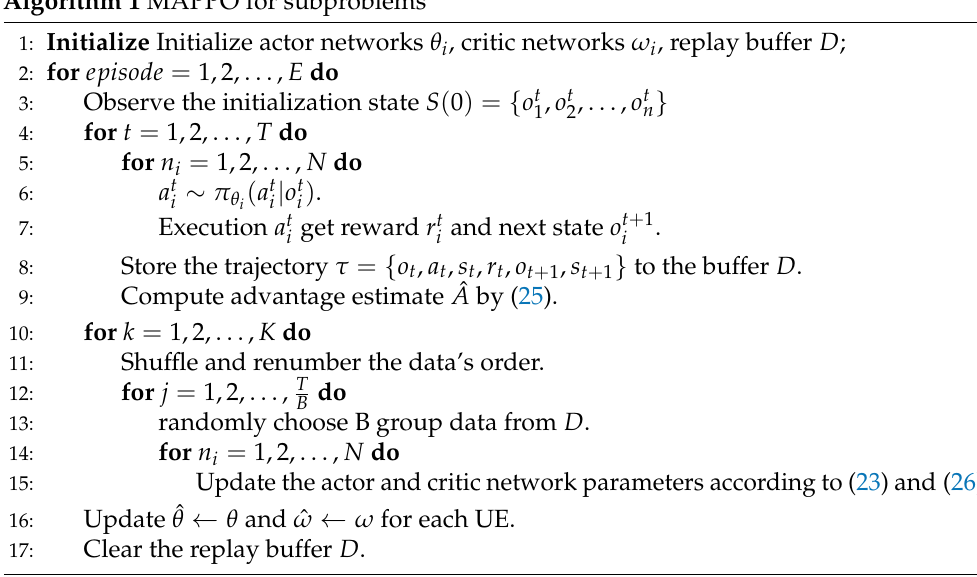
Algorithm 1 MAPPO for